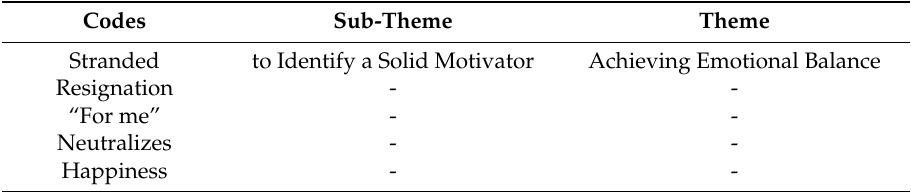
Table 2. Example of codes, a sub-theme, and a theme.